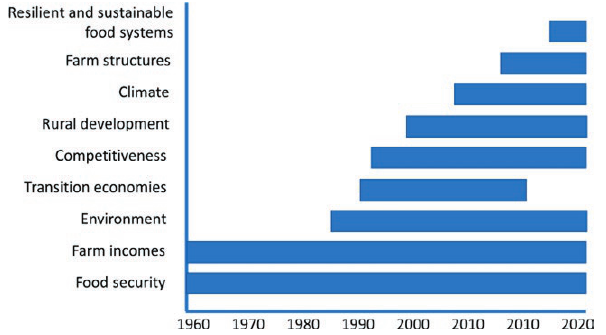
Figure 2. Overview of changes in CAP priorities over time. Source: Own